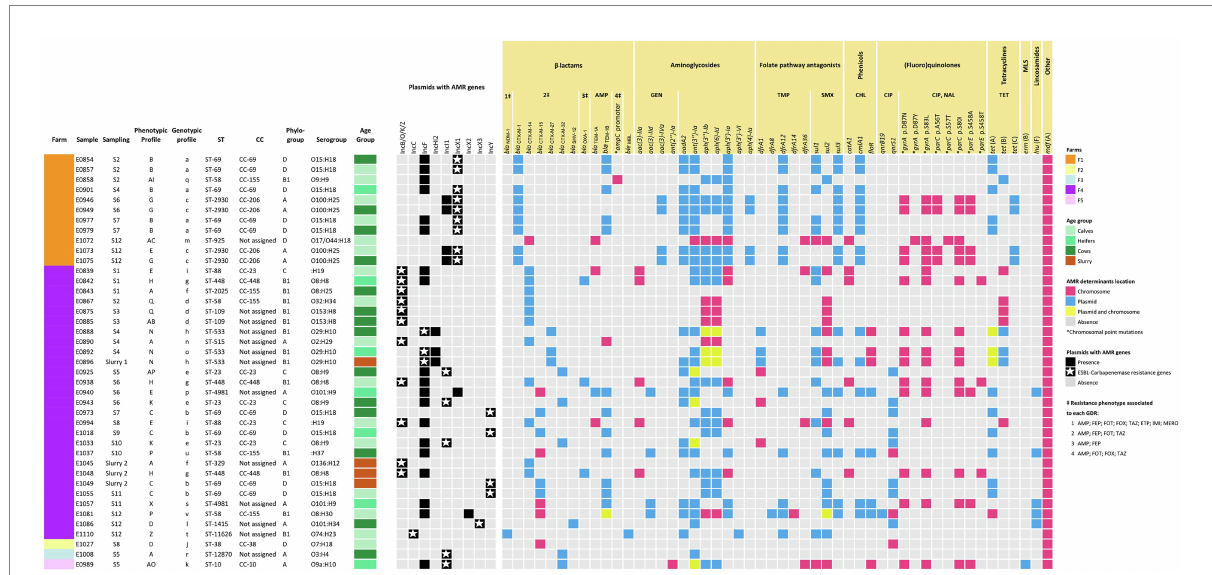
FIGURE 3 Heatmap showing the distribution of the AMR genes and plasmids detected by WGS (presence or absence and location are indicated as per the legend). Isolates are arranged per farm, sampling, and source (age group or slurry). Additional information including MLST type (ST and CC), phylogroup, and serogroup are included. AMR phenotypic resistance profiles are as indicated in Figure 2 and described in Supplementary Table S1. Each AMR genotypic profile resulting from an identical combination of GDR is represented with a letter of the Latin alphabet in lower case. The resistance phenotypes associated with each GDR are indicated for those antimicrobials tested, which were abbreviated as follows: ampicillin (AMP), cefepime (FEP), cefotaxime (FOT), cefoxitin (FOX), ceftazidime (TAZ), ertapenem (ETP), imipenem (IMI), meropenem (MERO), gentamicin (GEN), trimethoprim (TMP), sulfamethoxazole (SMX), chloramphenicol (CHL), nalidixic acid (NAL), ciprofloxacin (CIP), tetracycline (TET). MLS, macrolide-lincosamide-streptogramin. Descriptions of the phenotypic and genotypic profiles of resistance can be found in Supplementary Tables S1 and S3,